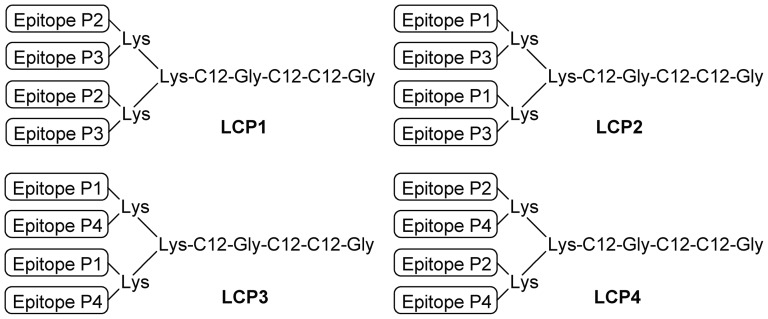
Schematic representation of lipid core peptide (LCP) constructs.Epitopes from P. yoelii circumsporozoite protein (PyCSP) as follows: P1 = PyCSP280–288, SYVPSAEQI; P2 = PyCSP280–295, SYVPSAEQILEFVKQI; P3 = PyCSP58–67, IYNRNIVNRL; P4 = PyCSP57–70, KIYNRNIVNRLLGD. See
Materials and Methods
 and
Table 1
 for additional details.